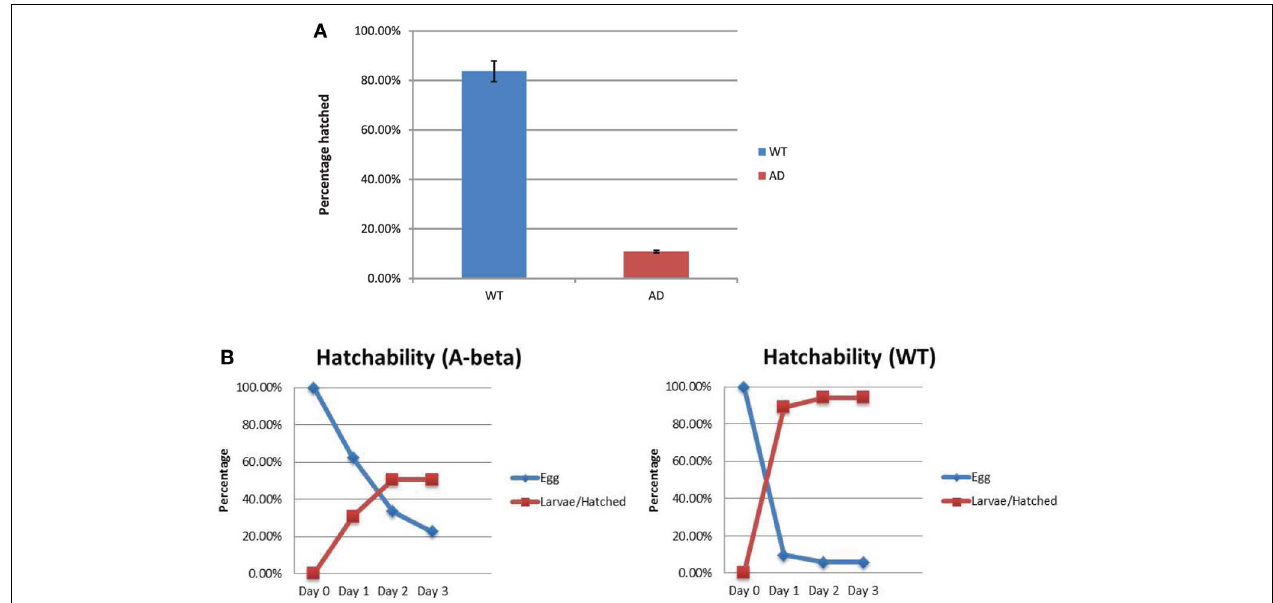
FIGURE 4 | Rate of egg hatching (hatchability) in the WT and AD strains. (A) Percentage of eggs unhatched after 24h. There were more AD eggs (red) that remained unhatched compared to the WT eggs (blue).